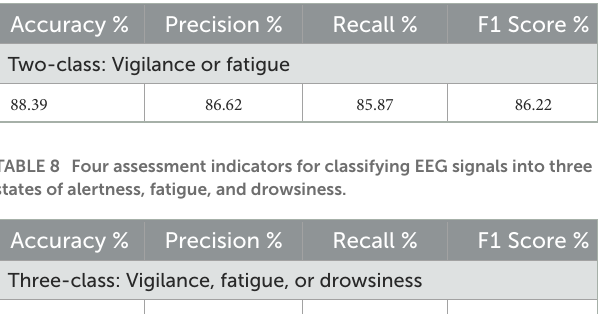
TABLE 7 Four assessment indicators for classifying EEG signals into alert and fatigue states.